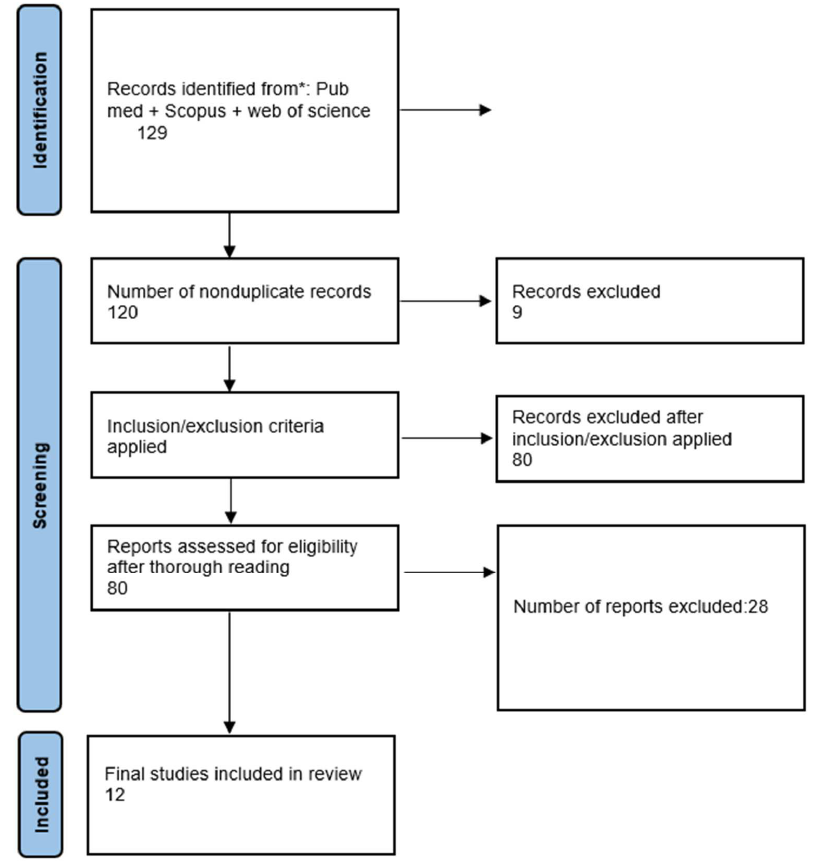
Figure 2. PRISMA flowchart of results [21].